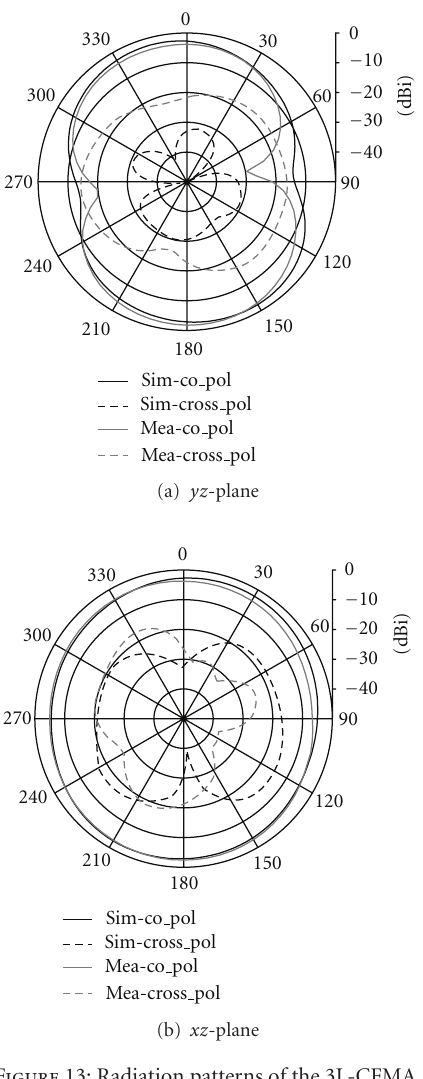
Figure 13: Radiation patterns of the